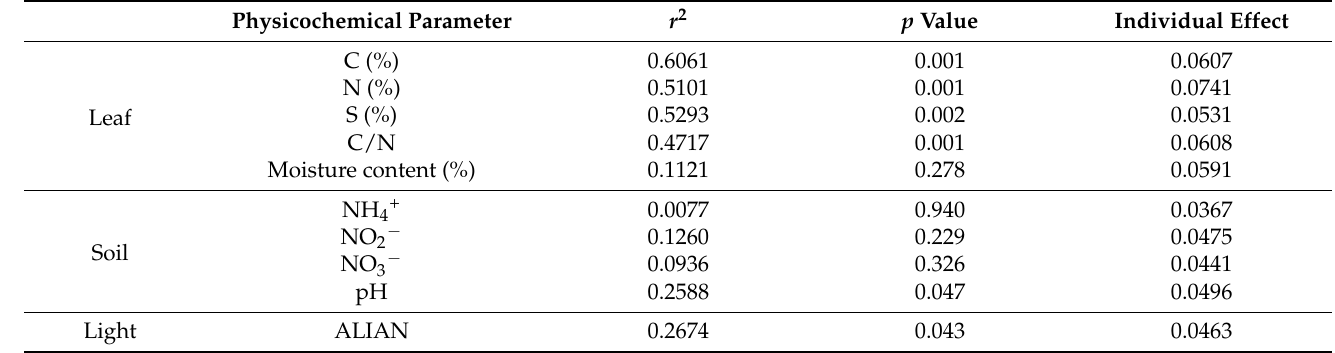
Table 2. RDA (Redundancy analysis) of leaf phyllosphere microbiota of different urbanization levels.